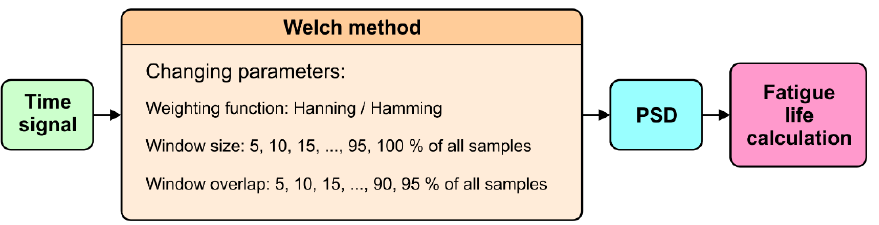
Figure 1. Design of experiment flow chart.